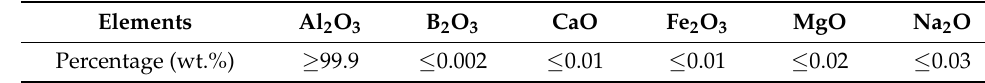
Table 2. Composition of alumina powder.